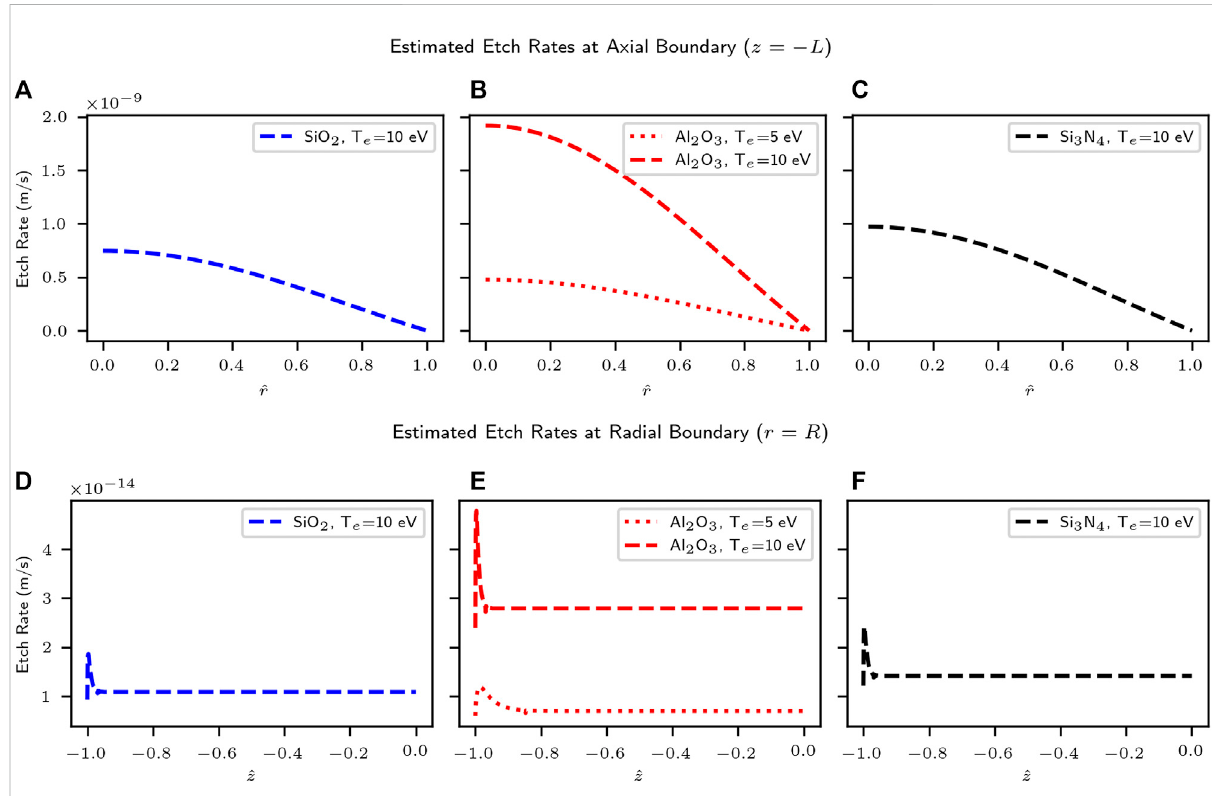
FIGURE 9 Estimated etch rates at the inner surfaces of the boundary dielectric containment material in the VX-CR device, as obtained through the combination of the density distribution, sheath and sputtering models described in Section 2. The etch rates for the axial ( z = − L ) boundary, the endplate located attheupstream end ofthedielectriccylinder,are presented inthetop row inplots (A) , (B) and (C) ;thecorresponding etch ratesfor the radial ( r = R ) boundary, the inner surface of the dielectric cylinder, are presented in the bottom row in plots (D) , (E) and (F) . Estimations